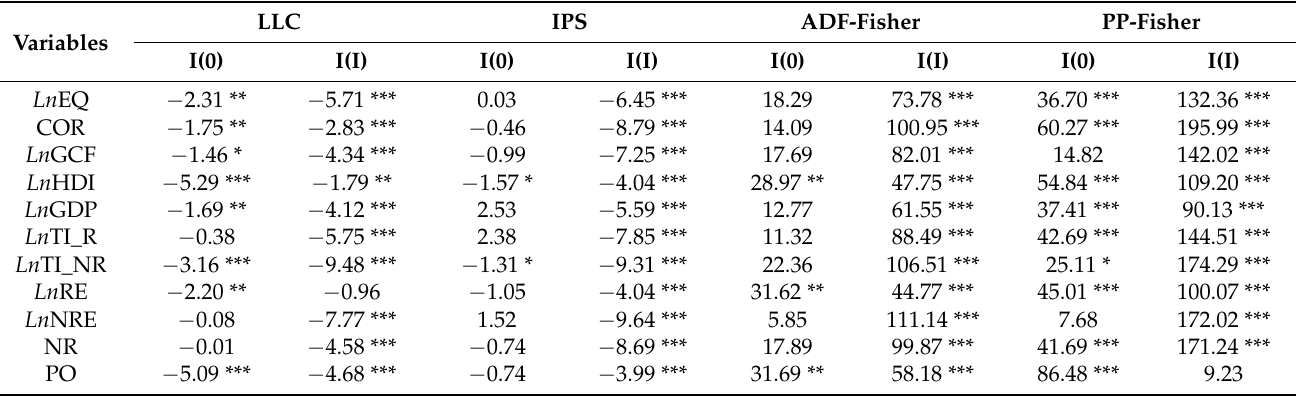
Table 4. Panel unit root